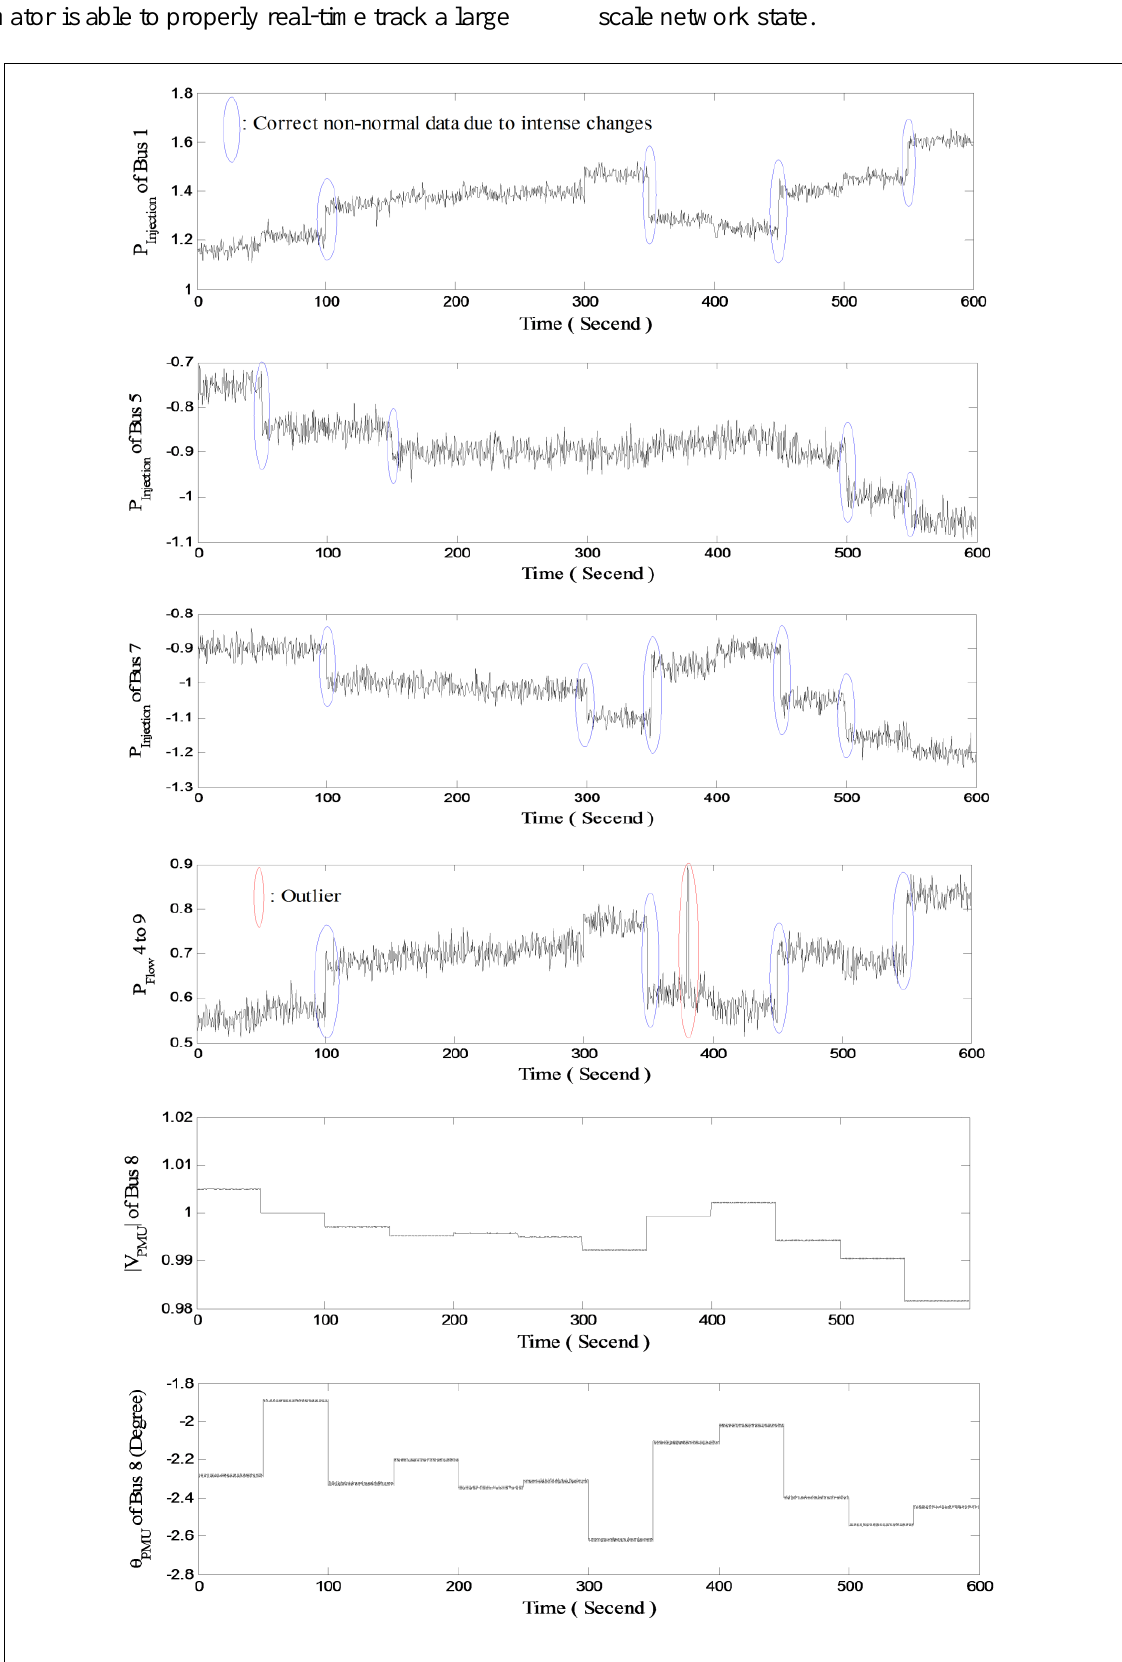
Figure 8. Some understudied system measurement data: conventional measurements and